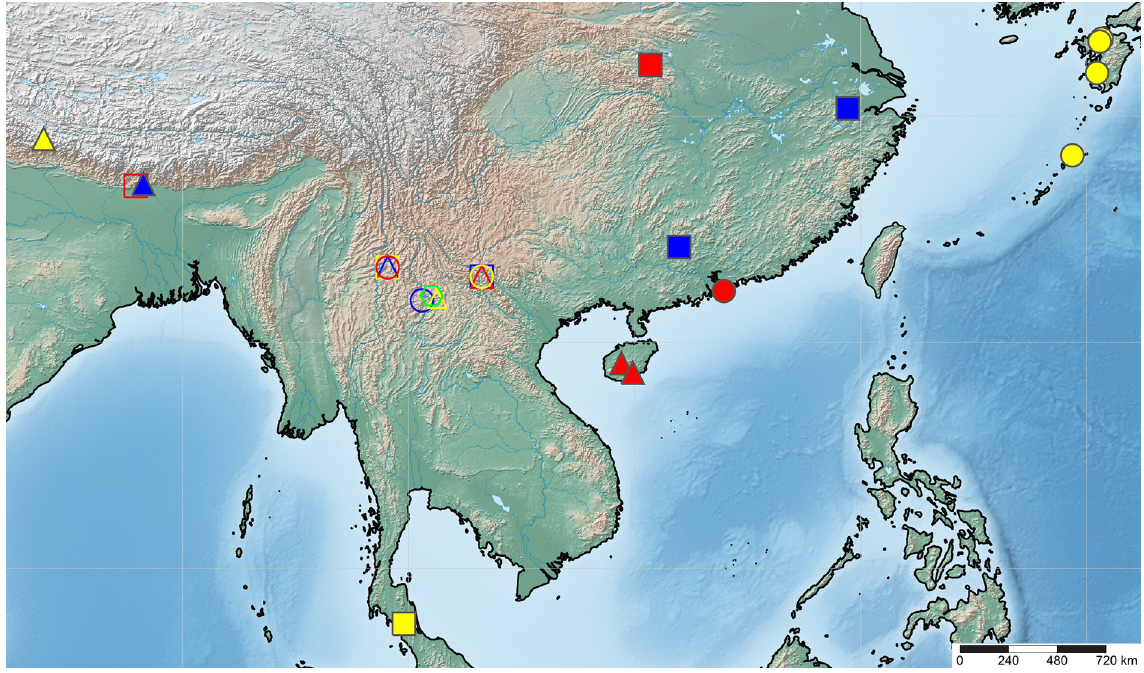
Fig. 32. Distribution map of Kokeshia spp. Red open circle = K. acutiformis sp. nov.; red solid circle = K. baii sp. nov.; blue open triangle = K. bui sp. nov.; blue open circle = K. caii sp. nov.; yellow open circle = K. drepanoides sp. nov.; yellow solid circles = K. esakii Miyamoto, 1960; red open triangle = K. hilli sp. nov.; blue solid squares = K. hsiaoi Ren & Zheng, 1992; red open square = K. martensi Štys, 1985; yellow solid square = K. oroszi Rédei, 2008; yellow open triangle = K. pengae sp. nov.; green open hexagon = K. redeii sp. nov.; yellow open square = K. renae sp. nov.; yellow solid triangle = K. similis Štys, 1985; blue solid triangle = K. stysi Rédei, 2008; blue open square = K. weirauchae sp. nov.; red solid triangles = K. xiei Rédei, Ren & Bu, 2012; red solid square = K. zhengi Rédei, Ren & Bu,